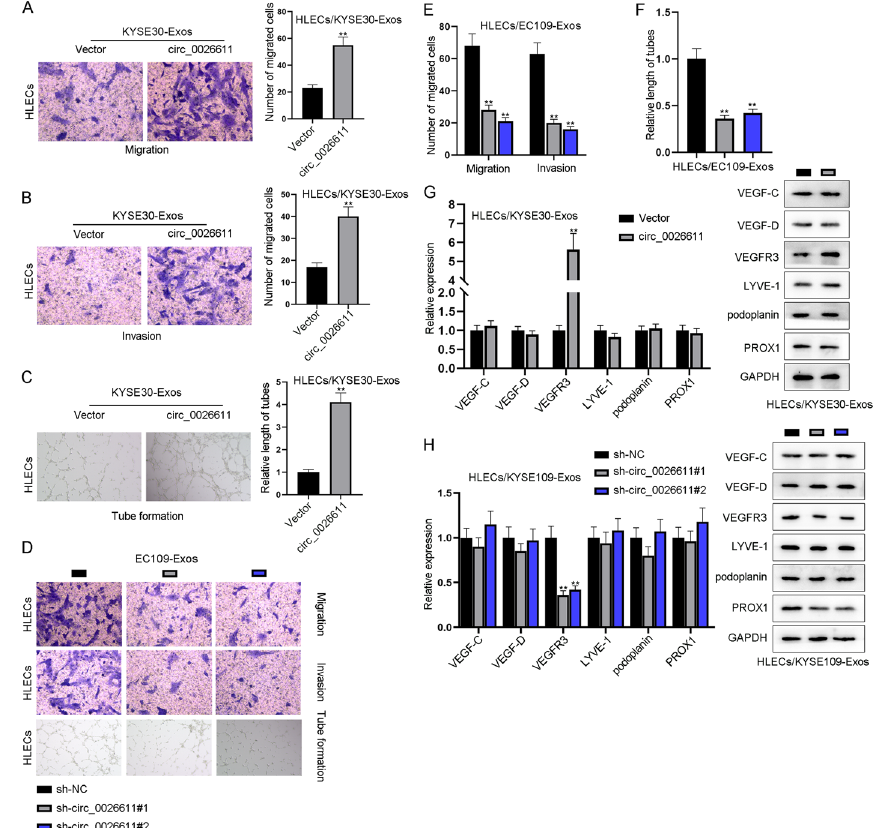
Fig. 3 ESCC cell-derived exosomes promoted HLEC migration, invasion, and lymphangiogenesis by delivering circ_0026611. A – F Functional assays were carried out to evaluate the impact of circ_0026611-overexpressing ESCC-derived exosomes on the migration, invasion, and tube formation of HLECs. G , H The expression of lymphangiogenesis-related markers in different groups. ** P <